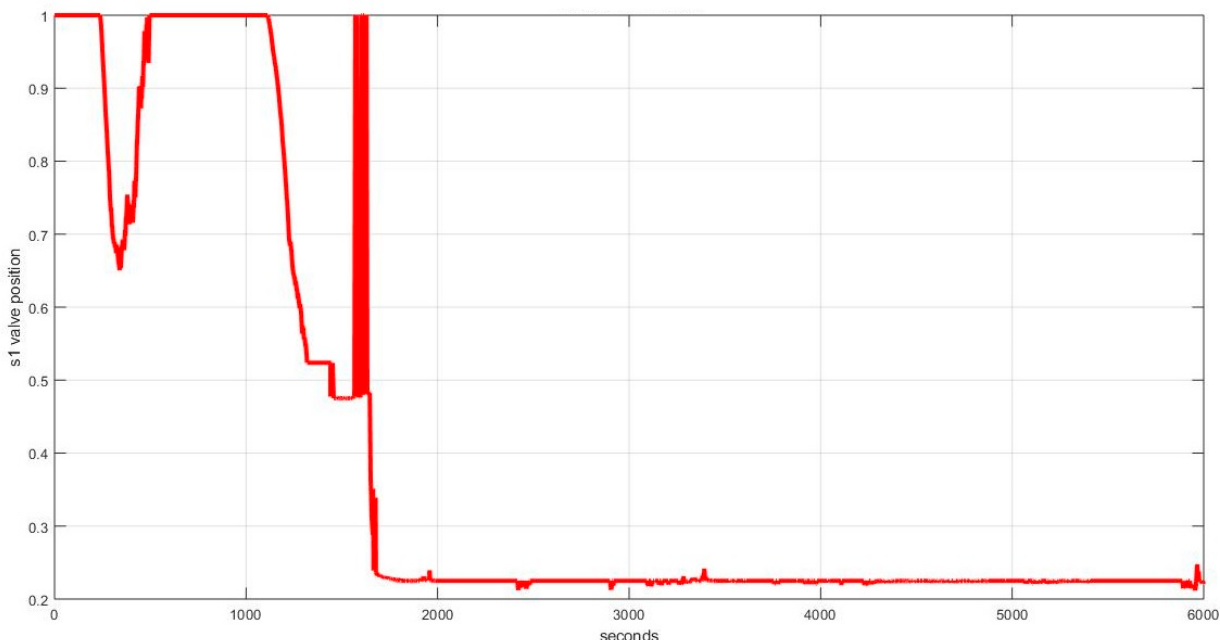
Figure 21. U1 control variable indicating the water inflow for case of white noise disturbance.